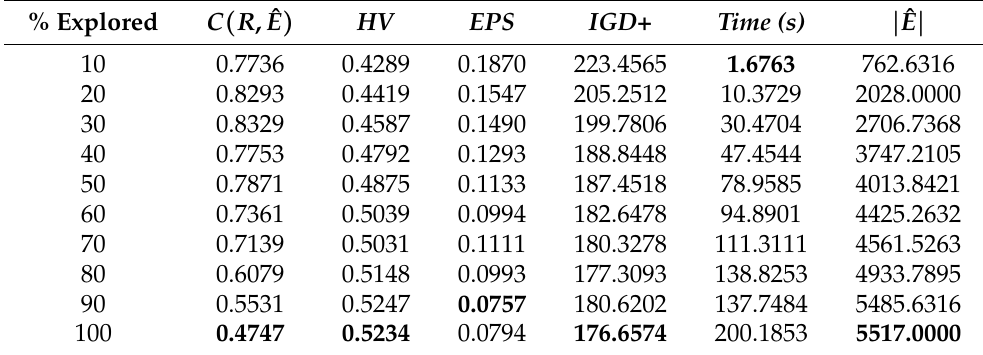
Figure 2. Evolution of the coverage and hypervolume when constructing from 100 to 1000 GRASP solutions. Table 6. Evolution of the performance of the local search procedure when considering different percentages of elements to be